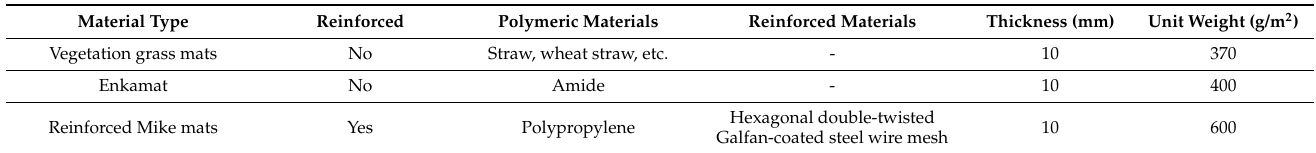
Table 2. Main technical parameters of experimental materials.